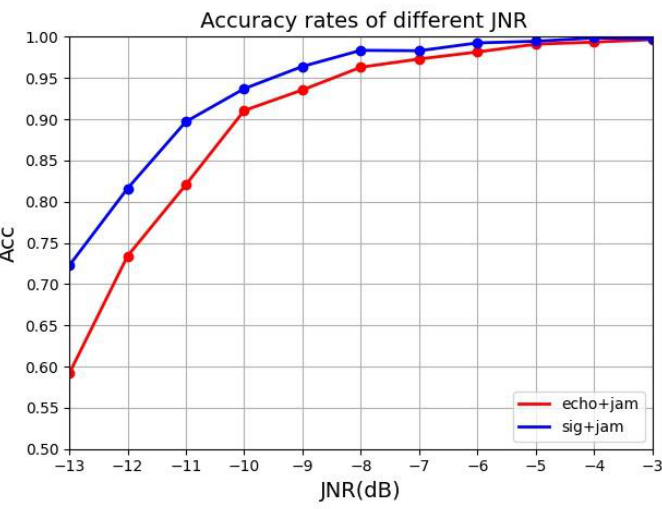
Figure 11. Comparison between jamming plus echo and jamming plus original signal.